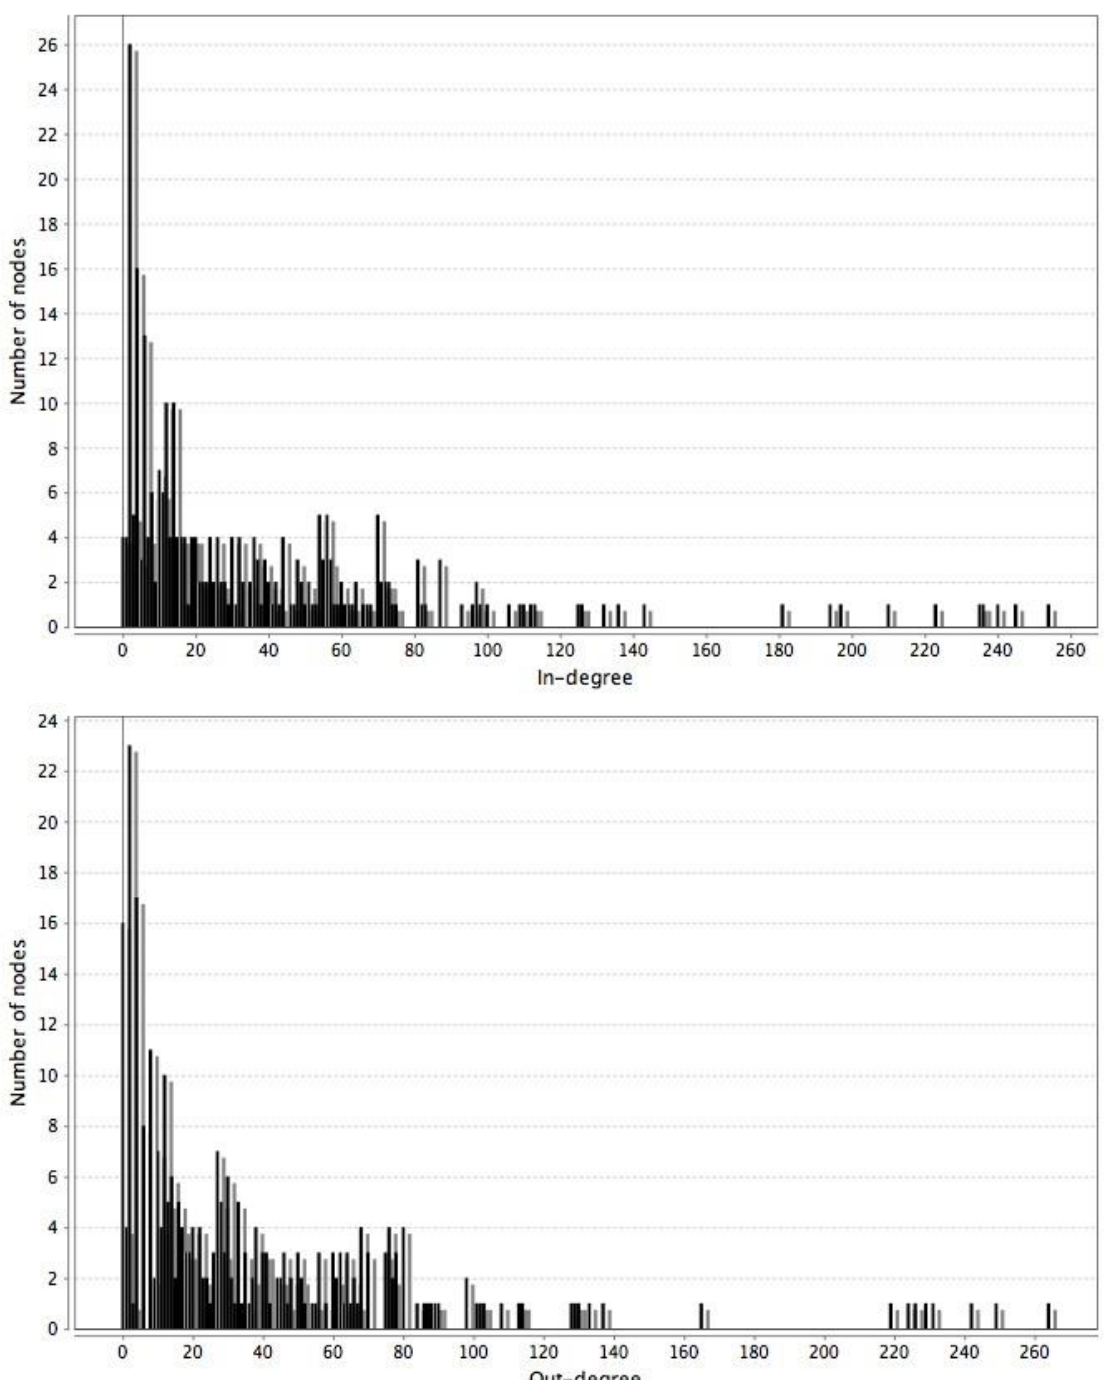
Figure 2 . In-degree (A) and out-degree (B) distribution of all the members in the indirect relations